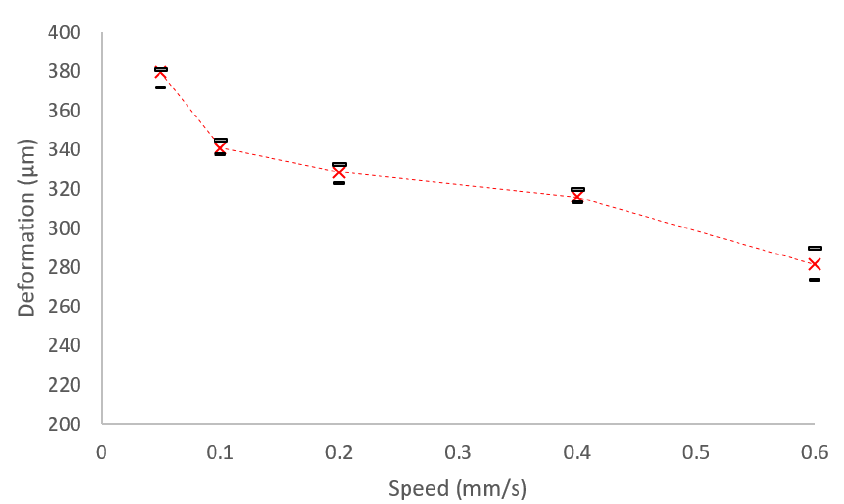
Figure 9. Deformation of Zebrafish embryo using different constant injection speeds.